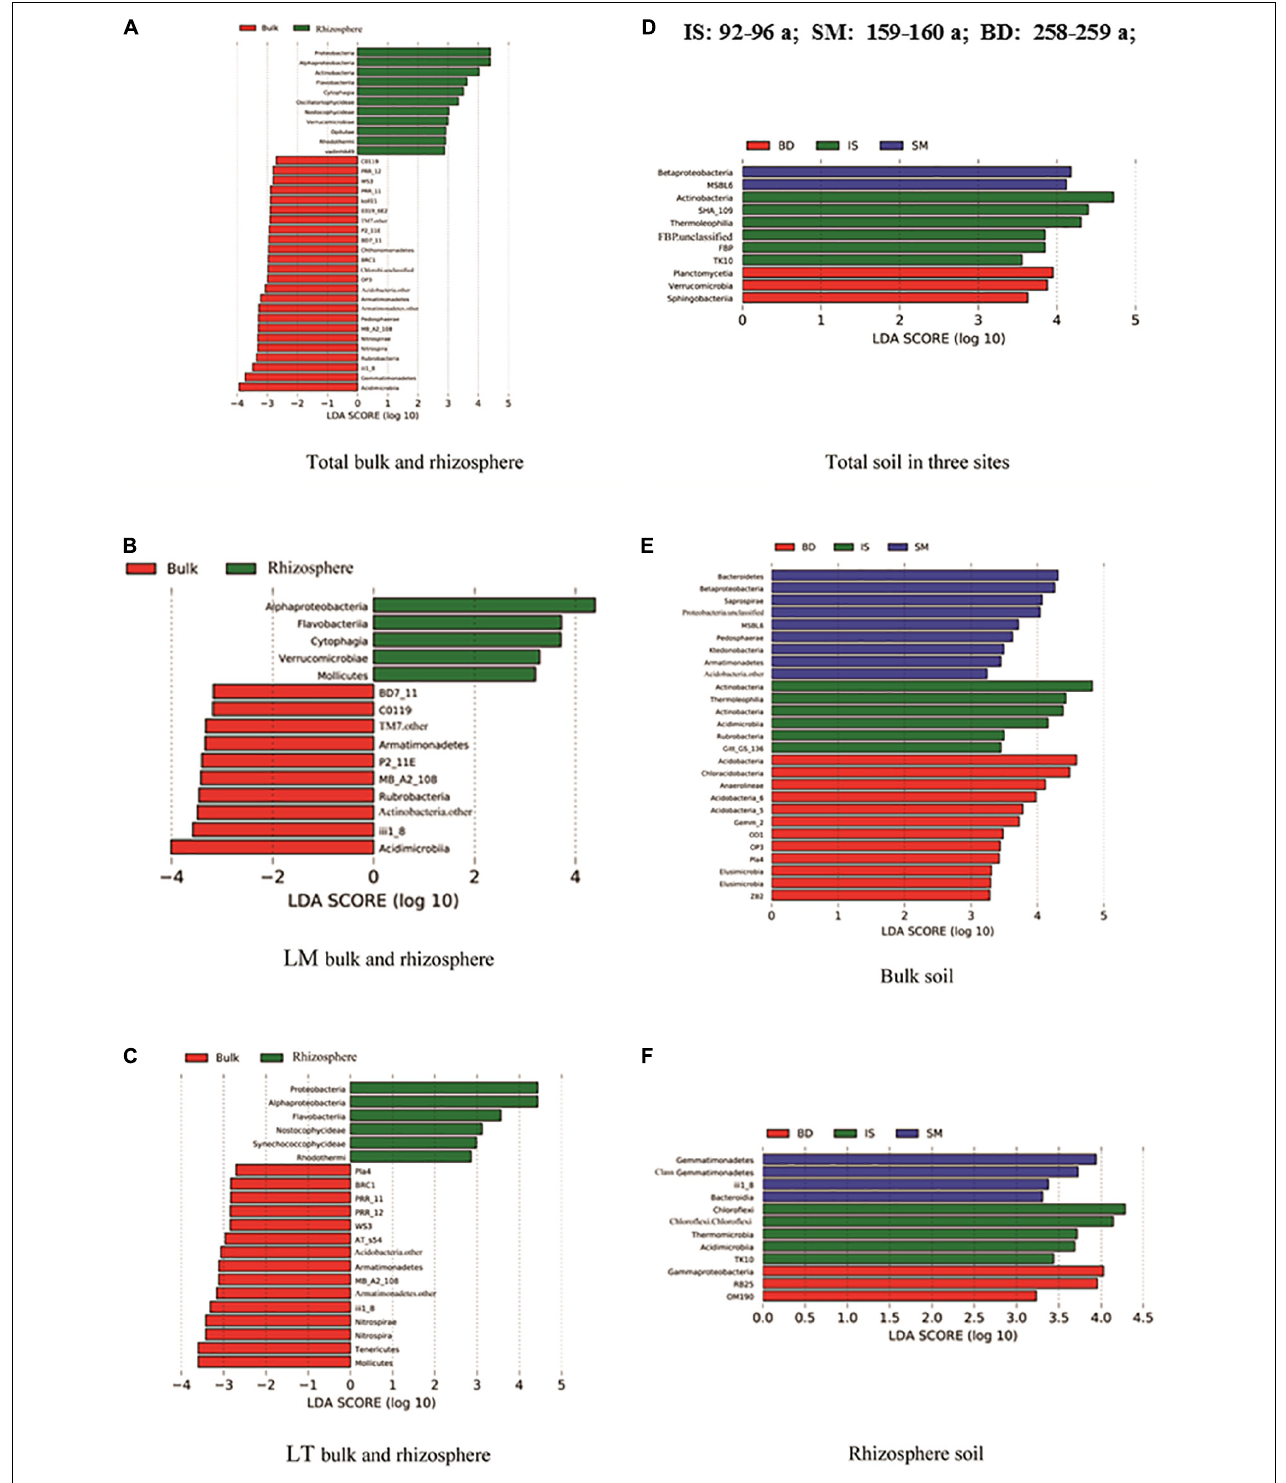
FIGURE 5 | LEfSe analyses of different sample groups. (A) For tobal bulk and rhizosphere soil, (B) for LM bulk and rhizosphere soil, (C) for LT bulk and rhizosphere soil, (D) for total soil in three sites, (E) for bulk soil, and (F) for rhizosphere soil. Sites: IS, middle of glacier terminal and small Qiangyong lake; SM, midway along the edge of the smaller lake; BD approximately one-third of the way along the edge of the larger lake. LM and LT indicate the sampling lines, Middle and Top, respectively; the different colors in the LE analysis represent different groups. The closer the sample distance is, the more similar the microbial compositions of the samples are, and the smaller the difference is ( P ≤